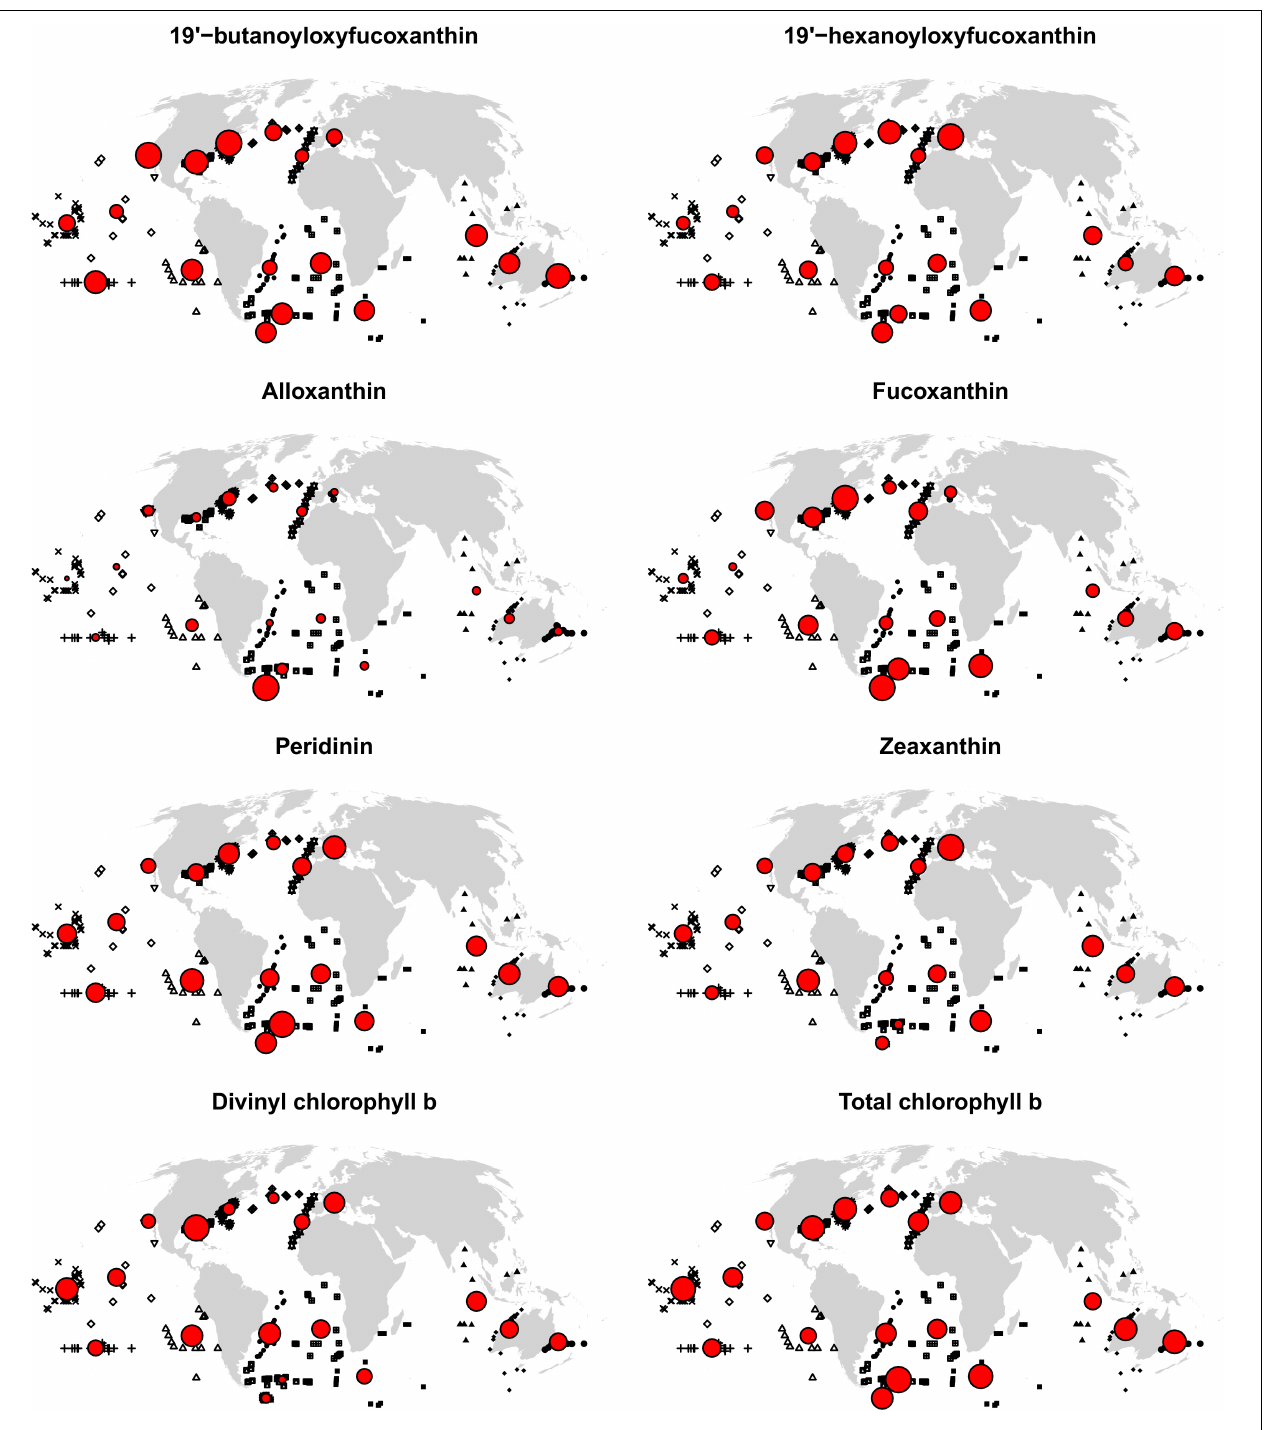
FIGURE 5 | MAEs for each spatial cross-validation block. In situ observations are shown in black, with symbols indicating blocks (see also Figure 1 ). Circles are centered on block centroids, and circle areas are proportional to block MAEs (errors when extrapolating to the block with an algorithm trained on all other blocks), standardized such that the block with the largest MAE for the respective pigment is represented with a circle of the same size in the eight maps. Consequently, circle sizes cannot be compared between pigments; and many large circles in a map do not imply large MAEs in absolute terms, but little variability of MAEs between spatial